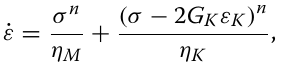
elements: Kelvin and Maxwell elements, which represent the transient and steady-state deformations, respectively (Fig. 3b). Kelvin element includes a spring and dashpot connected in parallel, whereas Maxwell element com- prises a spring and a dashpot joined in series. The strain rate in the spring of Maxwell element, dashpot of Max- well element, and dashpot of Kelvin element indicates the initial elastic response, steady-state viscous flow, and rapid transient viscous flow, respectively. As transient and steady-state deformations occur simultaneously, the strain due to the transient and steady-state deformations is connected in series. For Burgers rheology, the strain ˙ ε rate ( ) as a function of time ( t ) can be expressed as fol- lows (Karato 2008, 2021; Freed et al.